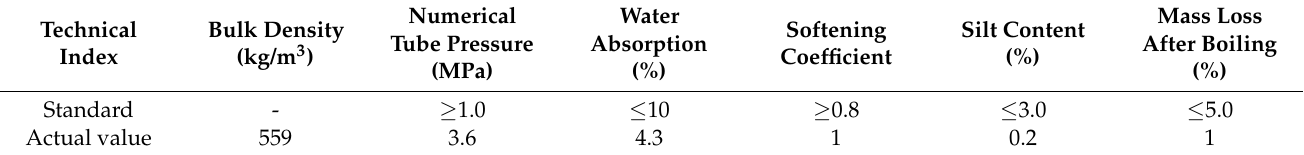
Table 2. The performance indices of the shale ceramsite.